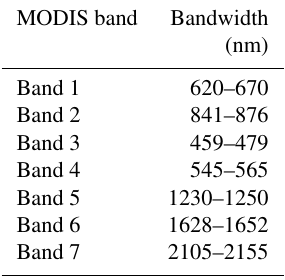
Table 1. MODIS sensor reflective band 1–7